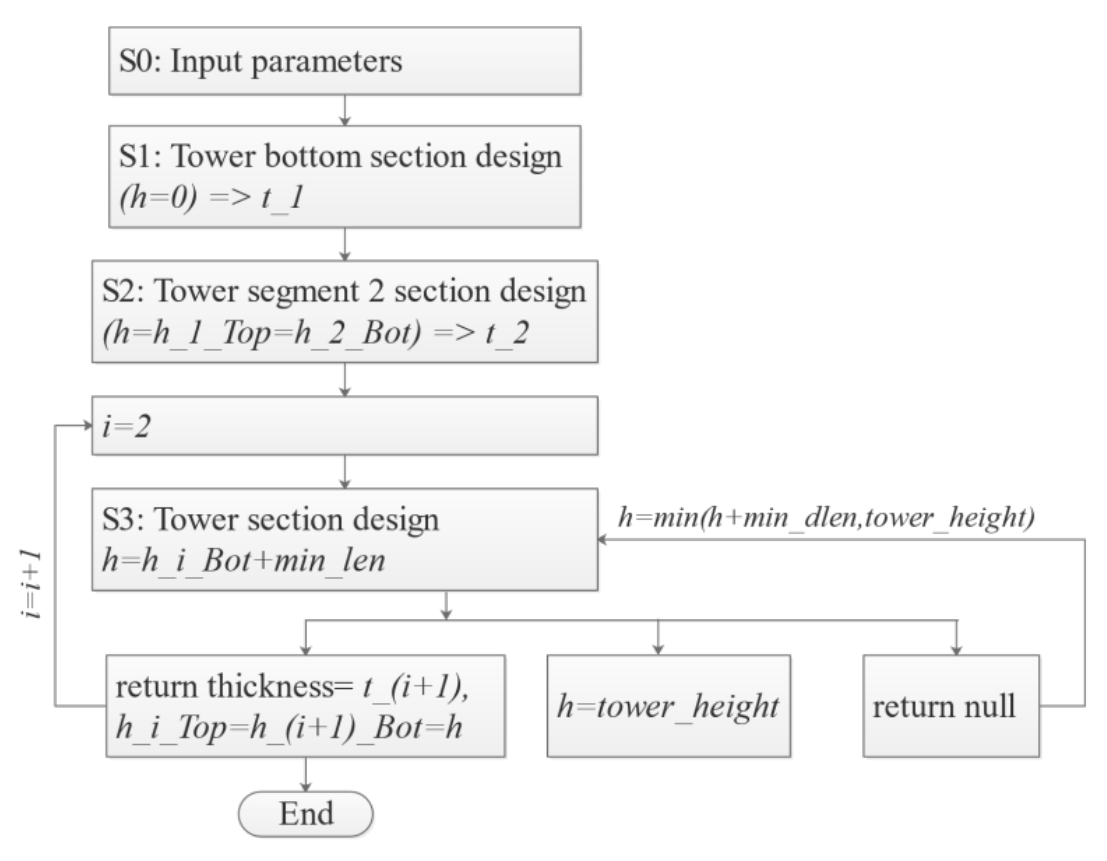
Figure 3. Level 1-Tower segment design flow